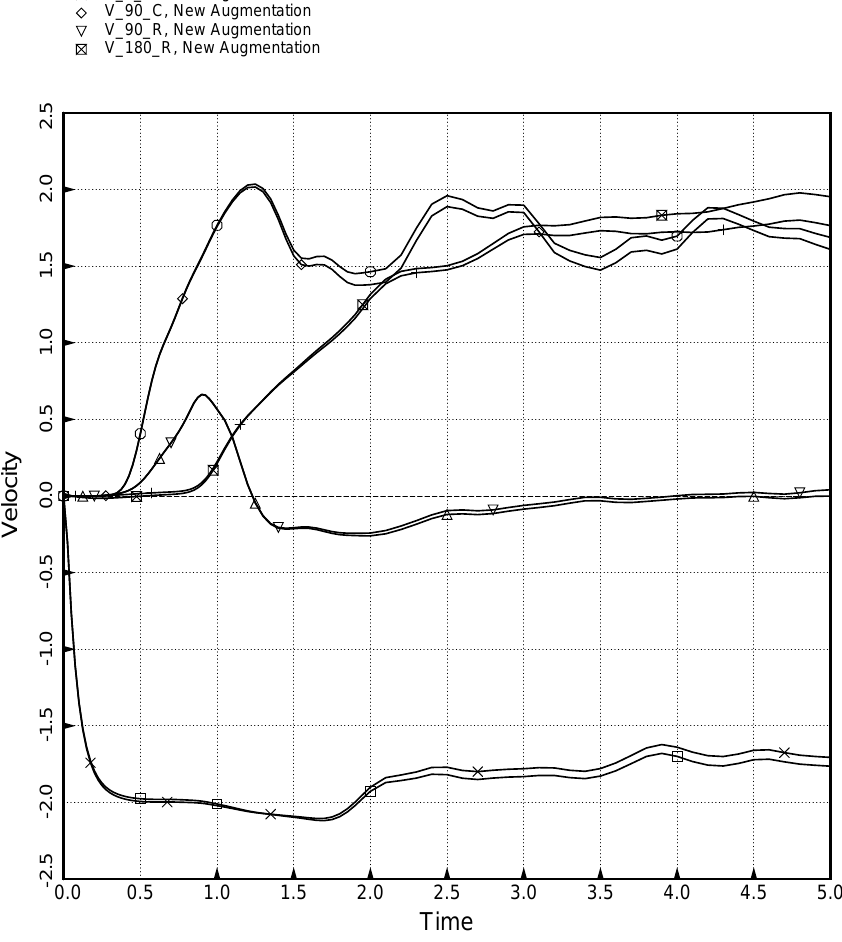
Fig. 3. Cylinder, DAA 1, Singular mass in new